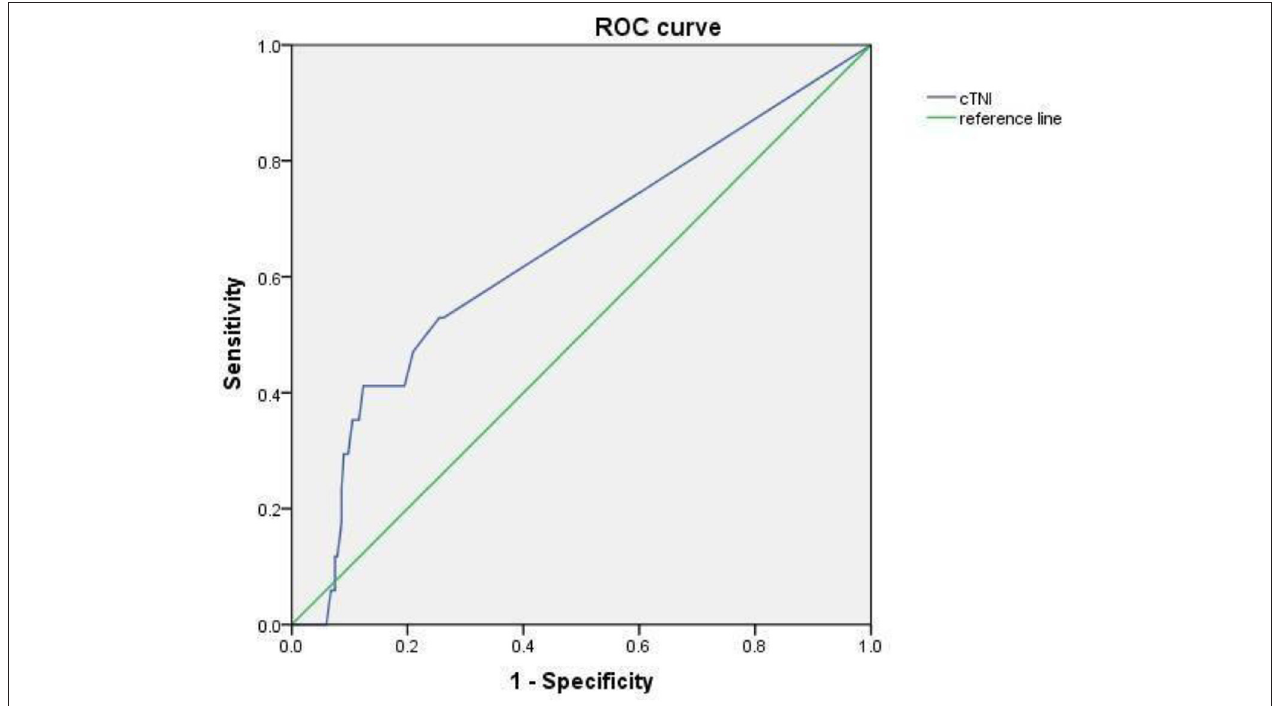
FIGURE 4 | The ROC curve of cTnI levels in predicting CAL in children with